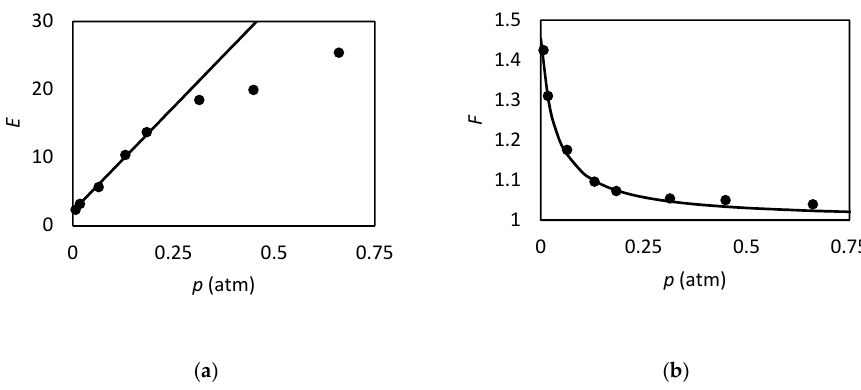
Figure 13. Modeling results using Equation (3.22). ( a ) Plot of E = ( F − 1) − 1 as function of upstream pressure. At high pressure, the linearity is lost. ( b ) Facilitation factor calculated by using parameters retrieved in the low pressure range of figure a. Circles are experimental data from Tsuchida et al. [127], lines come from Equation (183).